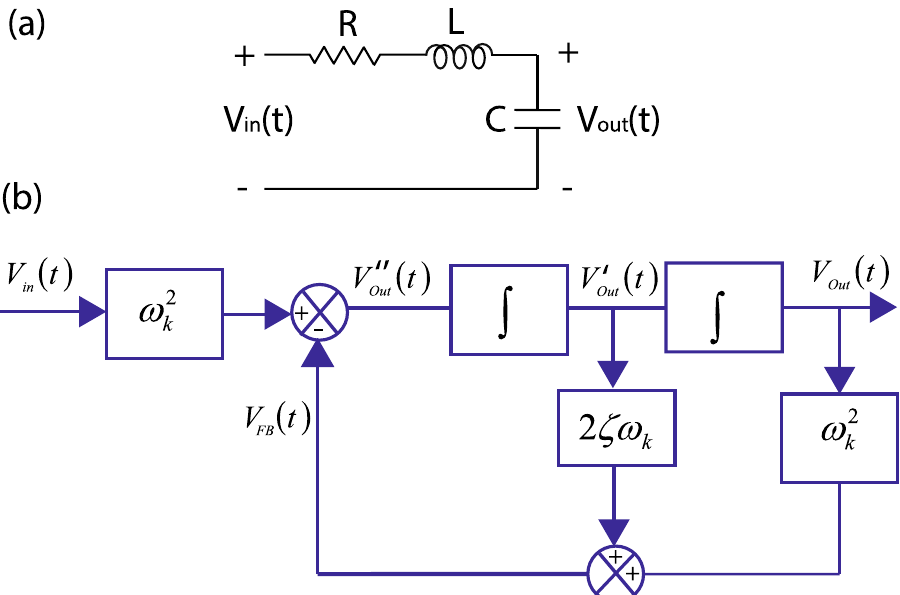
Figure 6. Circuit based model of feedback. ( a ) A resistor R , capacitor, C and an inductor L in series represents the circuit equivalent model of a given specimen subjected to an input voltage radio frequency voltage V in . ( b ) A block diagram based representation of Eq. 18 is shown here. V ′′ Out ( s ) and V ′ Out ( s ) denote the second and the first derivative of output voltage. V Out and V Out ( t ) are fed back to the